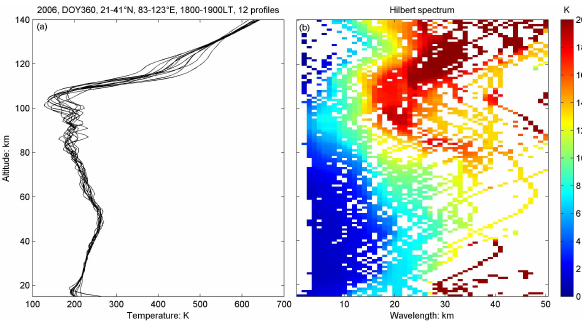
Fig. 5. An example of the Hilbert spectrum (right) which was com- putered from one dozen Tn profiles (left). The height profiles were observed at 18:00–19:00LT on DOY 360, 2006 in the square area of 21–41 ◦ N, and 83–123 ◦